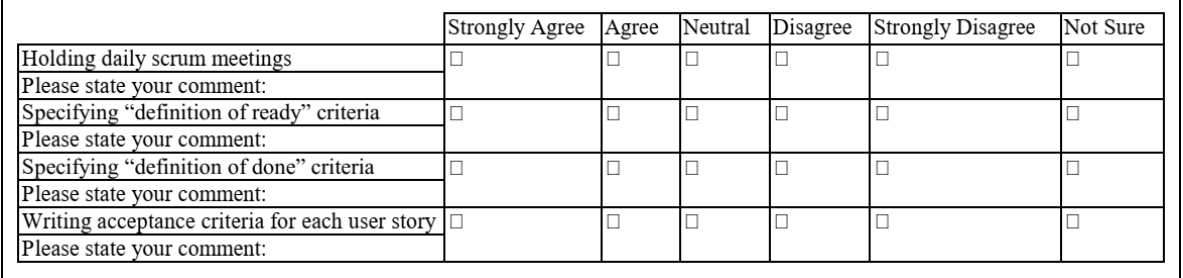
Figure A10. Questionnaire designed for obtaining feedback about the practices applied.